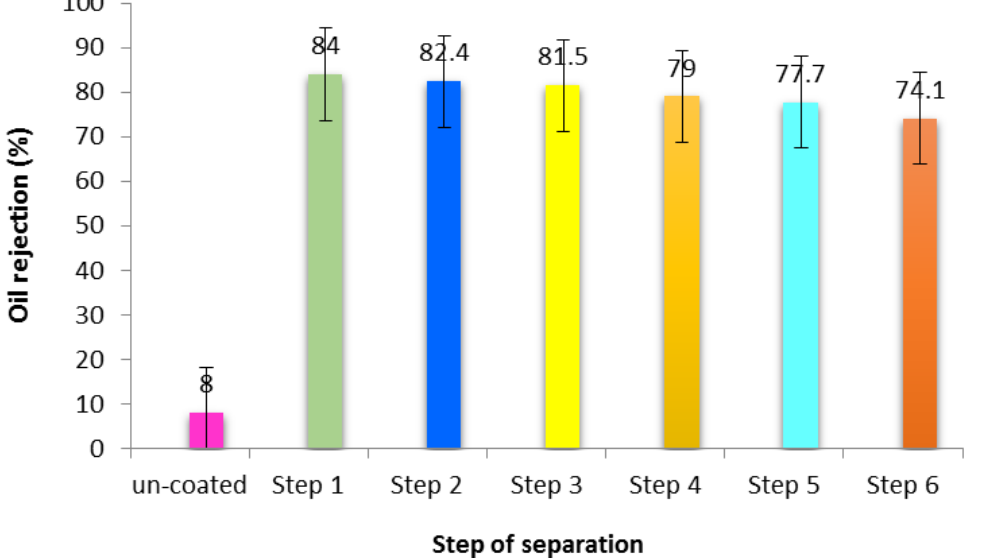
flux.Fig. 10. Oil rejections of the un-functionalized and functionalized Kevlar